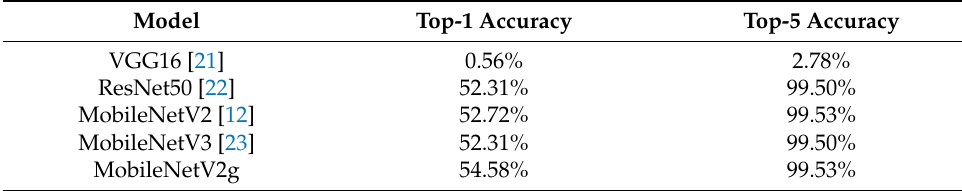
Table 2. Accuracies of different models.